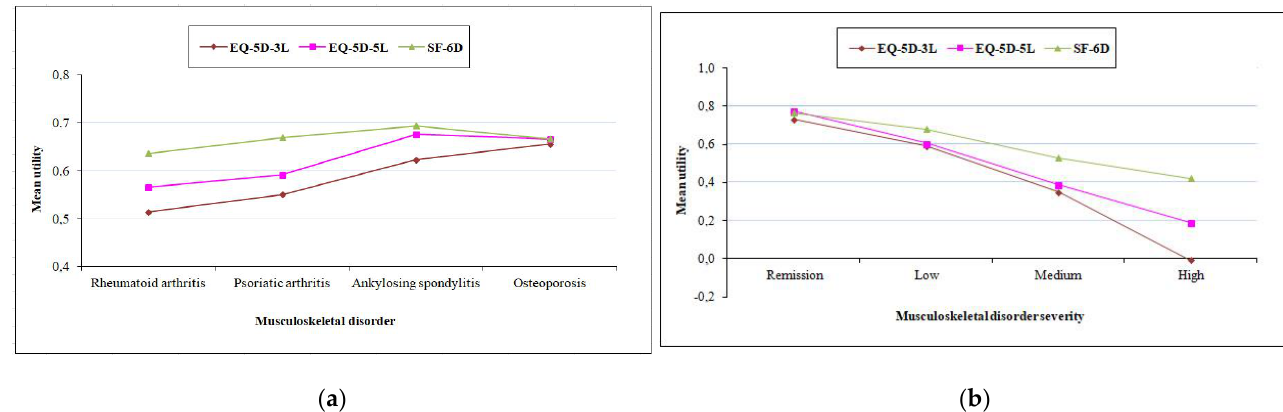
Figure 2). verity (Table 3, Figure 2).